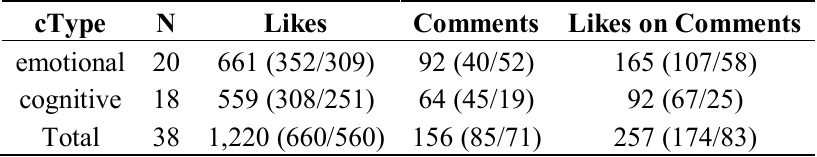
Table 1. Responses of messages by content